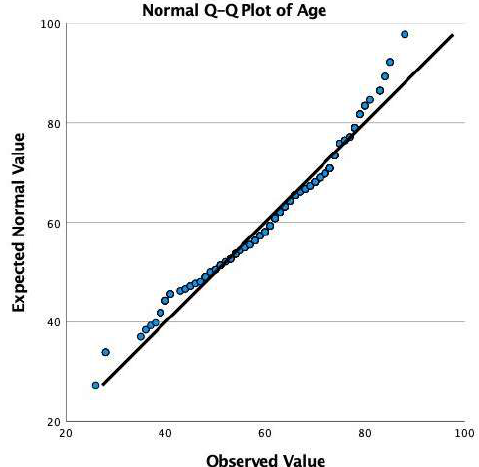
Figure 3. Q-Q Plot of expected versus observed values of age confirming the normal distribution of the 412 study patients’ age.